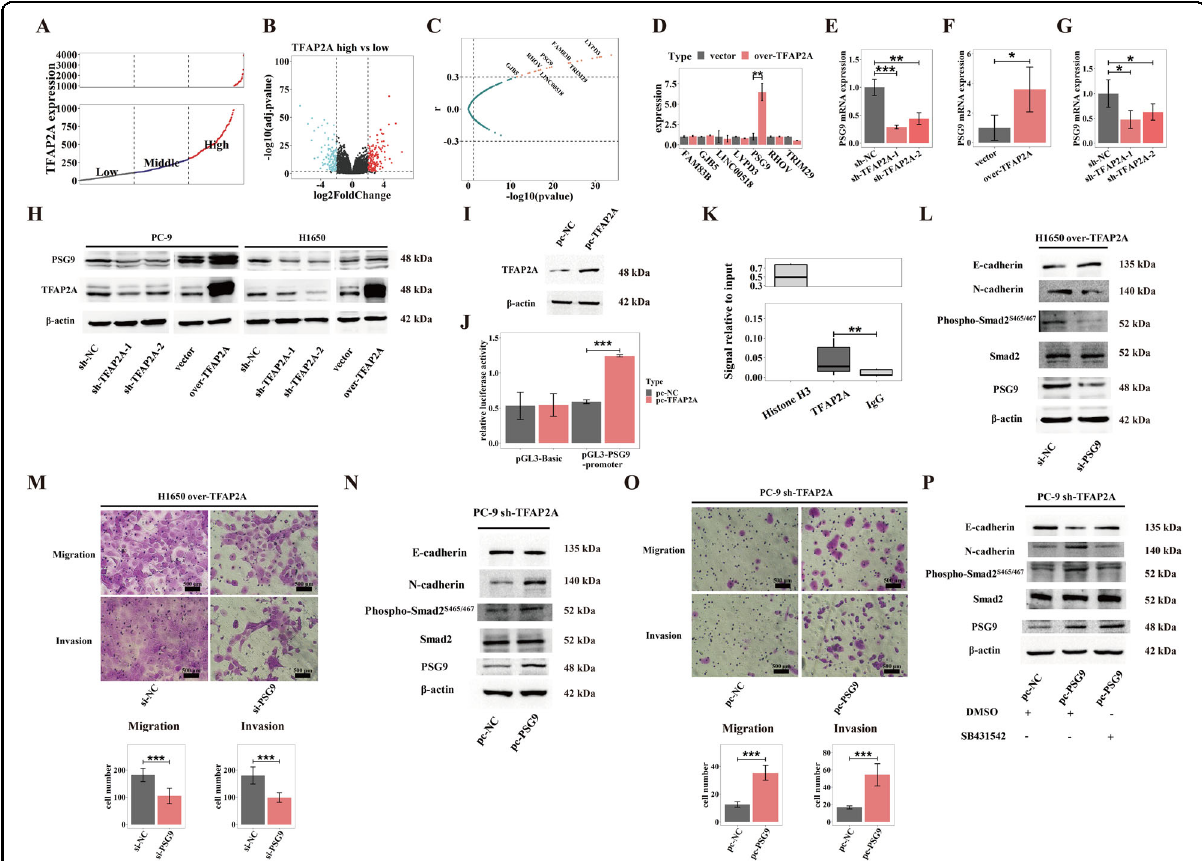
Fig. 5 TFAP2A promotes LUAD metastasis by transactivating PSG9 to potentiate TGF- β signaling. A 515 Patients in TCGA-LUAD dataset were divided equably into high, middle and low group based on TFAP2A expression. B Volcano plot exhibiting differentially expressed genes (DEGs) between TFAP2A high and low expression groups. C p -values and coef fi cients(r) of expression correlation analysis between TFAP2A and DEGs described in B , DEGs with p < 0.05 and r >0.3 or r < -0.3 were regarded signi fi cant, further DEGs with TFAP2A-ChIP-Seq evidence in hTFtarget database were picked out and texted. D Transcripts levels of seven identi fi ed possibly TFAP2A-targeted genes in TFAP2A overexpression cell models of PC-9. E PSG9 transcript levels in TFAP2A knockdown cell models of PC-9. F , G PSG9 transcript levels in TFAP2A overexpression and knockdown cell models of H1650 ( F , overexpression vs. control; G , knockdown vs. control). H TFAP2A and PSG9 protein levels for TFAP2A knockdown and overexpression cell models of PC-9 (left) and H1650 (right). I TFAP2A protein expression for TFAP2A overexpression cell models of HEK293T. J Effects for TFAP2A overexpression upon luciferase activity in HEK293T transfected with pGL3-Basic and pGL3-PSG9-promoter luciferase reporter (pc-TFAP2A vs. pc-NC). K Relative levels of immunoprecipitated PSG9 promoter regions (compared to Input chromatin) among positive control (Anti-Histone 3), negative control (Anti-IgG) and experiment group (Anti-TFAP2A) detected by qPCR. L EMT markers (E-cadherin/N-cadherin protein expression) and TGF- β signaling status (Phospho-Smad2 S465/467 /Smad2 protein expression) between PSG9 knockdown (si-PSG9) and control (si-NC) H1650 with stable TFAP2A overexpression. M Migratory and invasive abilities between PSG9 knockdown (si-PSG9) and control (si-NC) H1650 with stable TFAP2A over- expression. N EMT markers (E-cadherin/ N-cadherin protein expression) and TGF- β signaling status (Phospho-Smad2 S465/467 /Smad2 protein expression) between PSG9 overexpression (pc-PSG9) and control (pc-NC) PC-9 with stable TFAP2A knockdown. O Migratory and invasive abilities between PSG9 overexpression (pc-PSG9) and control (pc-NC) PC-9 with stable TFAP2A knockdown. P EMT markers (E-cadherin/ N-cadherin protein expression) and TGF- β signaling status (Phospho-Smad2 S465/467 /Smad2 protein expression) among control (pc-NC + DMSO), PSG9 overexpression (pc-PSG9 + DMSO), and PSG9 overexpression treated with TGF- β inhibitor (pc-PSG9 + SB431542) PC-9 with stable TFAP2A knockdown. * p < 0.05; ** p < 0.01; *** p < 0.001. N ≥ 3, Data are presented as mean ± SD or through